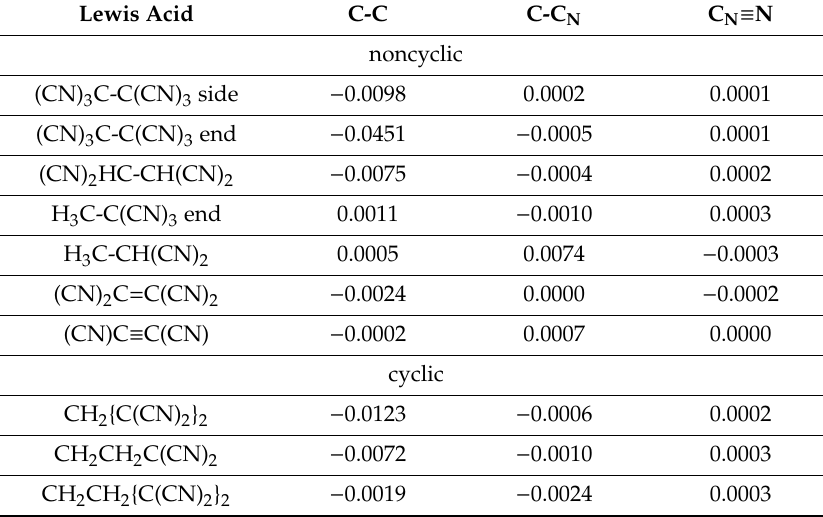
Table 2. Changes in internal bond lengths a (Å) caused by complexation with NH 3 .